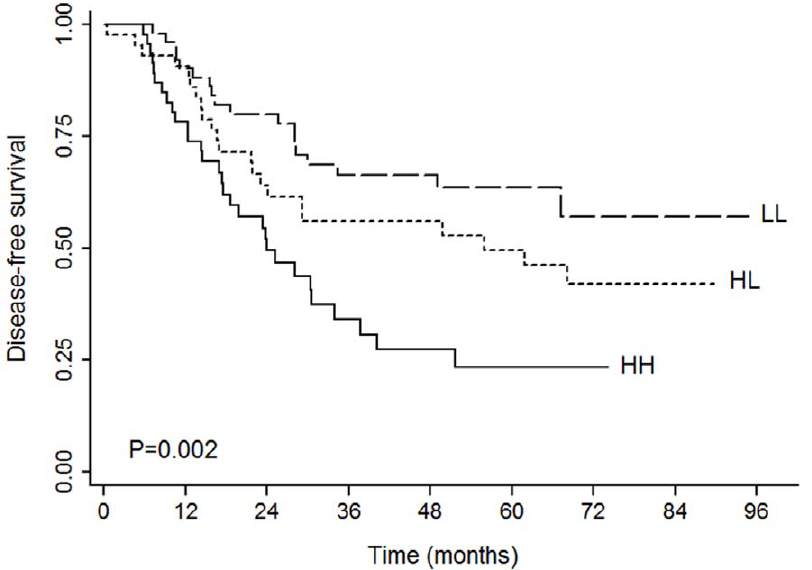
Figure 2. Kaplan-Meier plots of DFS according to the expression of CD31 and nucleolin in the entire cohort. HH: CD31 hi NCL hi , HL: CD31 hi NCL lo , and LL: CD31 lo NCL lo . doi:10.1371/journal.pone.0054674.g002 PLOS ONE | www.plosone.org 3 January 2013 | Volume 8 | Issue 1 |